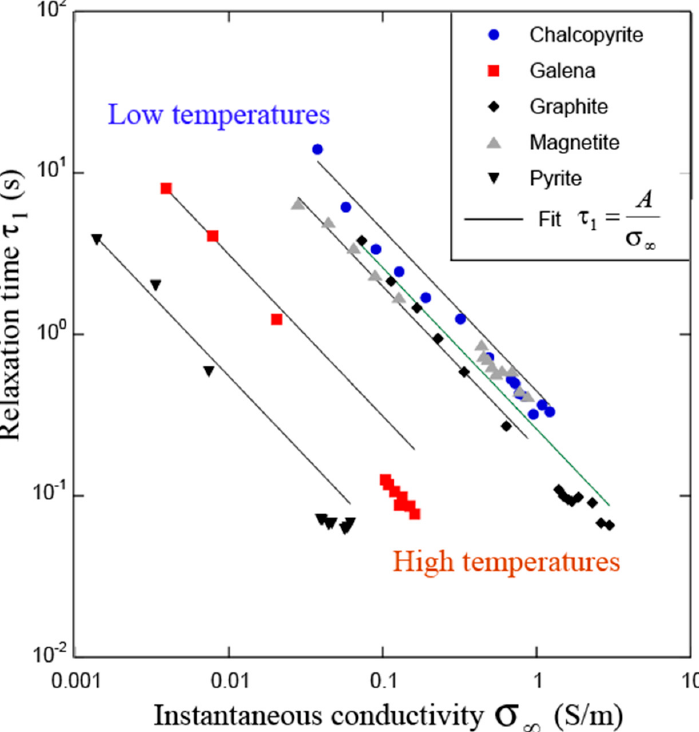
Figure 29. Relationship between the instantaneous conductivity and the low-frequency relaxation time for samples with metallic grains (galena, chalcopyrite, graphite, magnetite, pyrite) immersed in sand as background. The low-frequency relaxation time is inversely proportional to the instantaneous conductivity of the mixture. In the equation, A is a fitting constant for each material. Modified from [95].